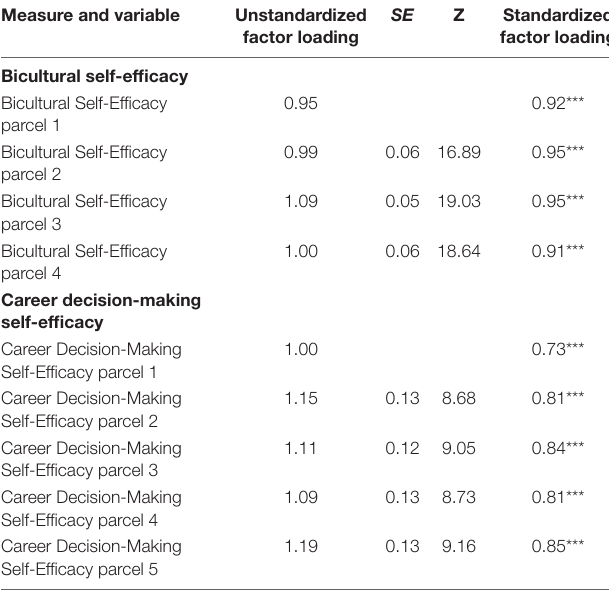
TABLE 2 | Factor loadings for the measurement model ( N =